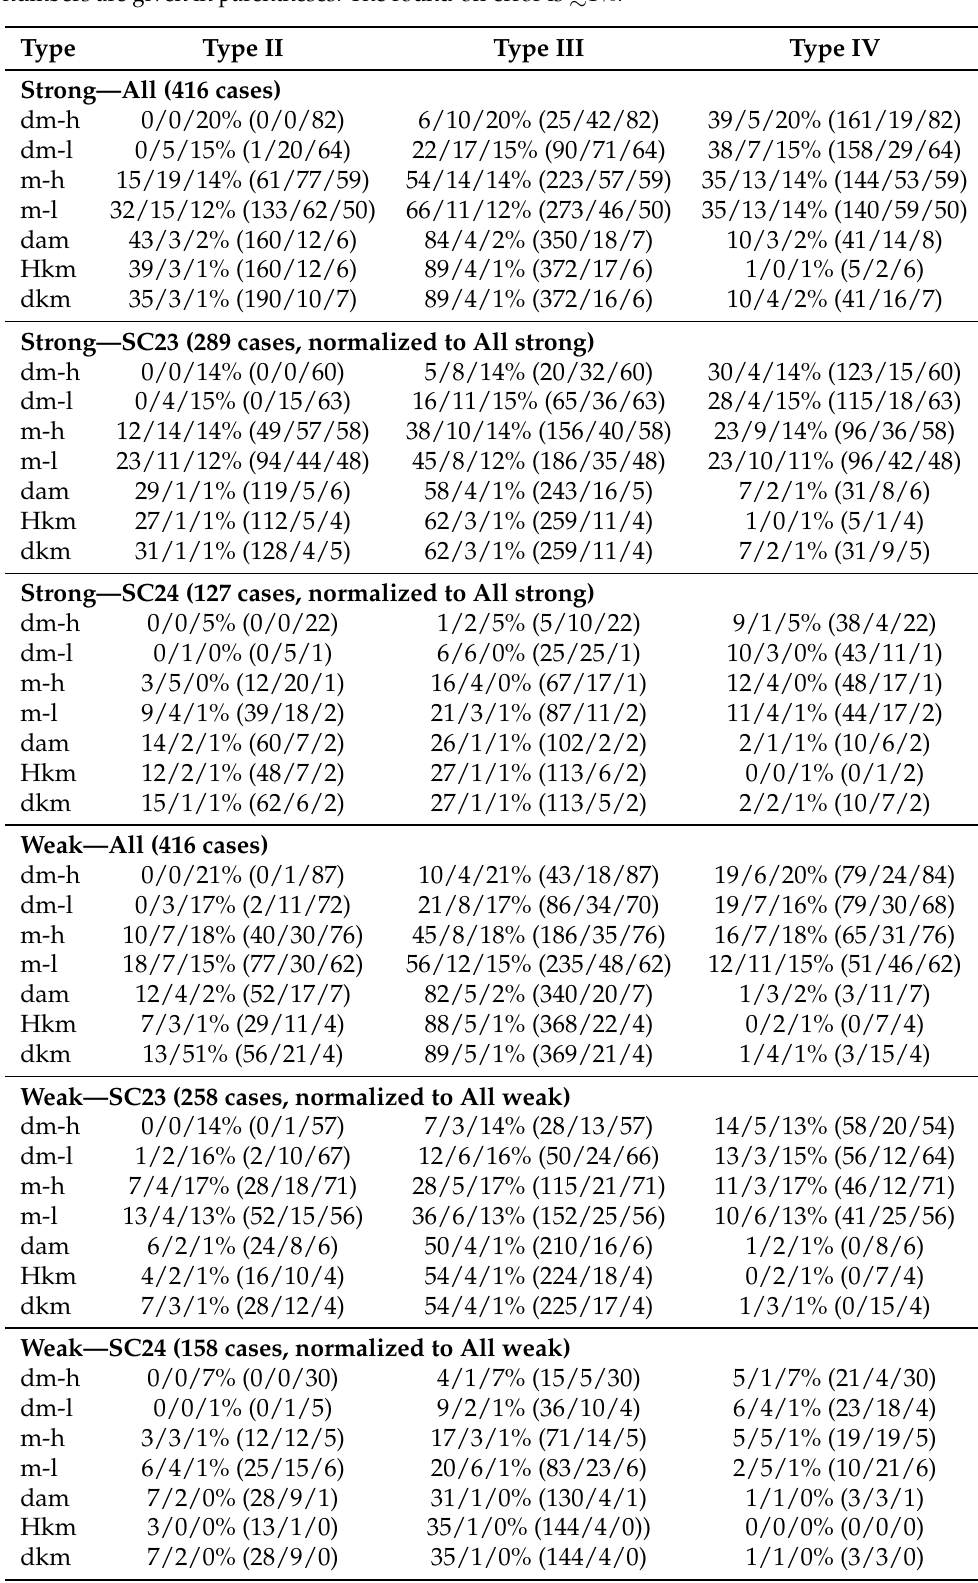
Table 5. Table of the occurrence of radio burst types II, III and IV in the different wavelength ranges for strong and weak SEE intensity, for All, SC23 and SC24 time periods. The results are shown as: visually identified/uncertain associations with observatory reports/data gaps, in % and the exact numbers are given in parentheses. The round-off error is (cid:46)